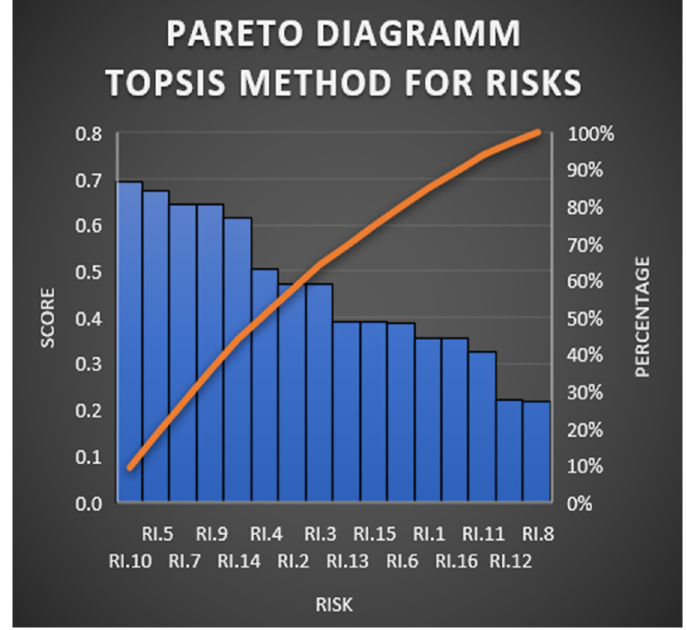
Figure 8. Risk—Pareto diagram using TOPSIS method for risks.